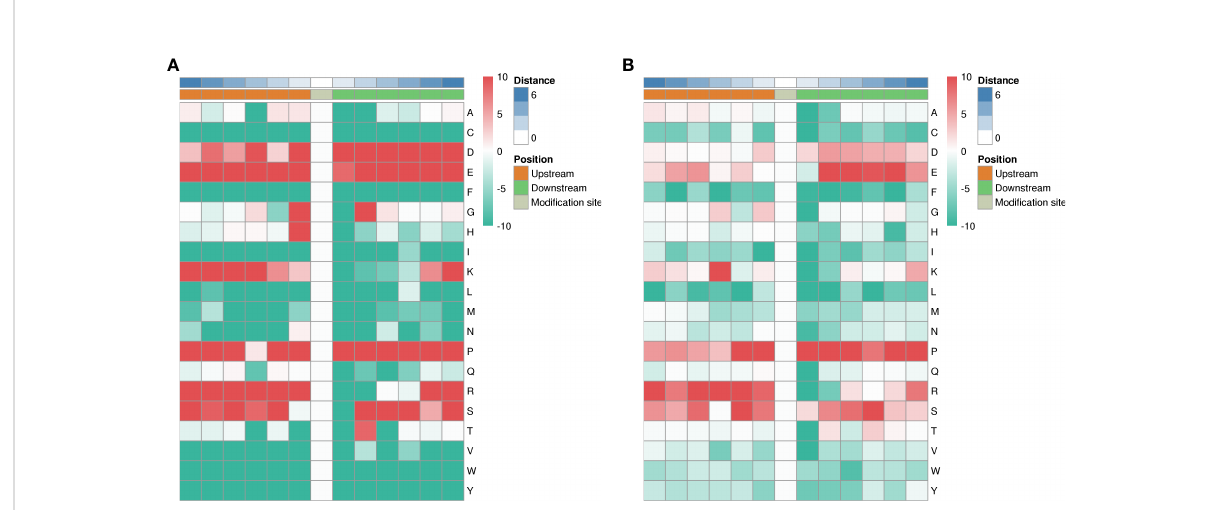
FIGURE 10 Motif analysis of phosphorylation sites. Heat map showing enrichment or depletion of speci fi c amino acids near the serine phosphorylation site. D, E, P, R, and S tend to be near the serine phosphorylation site (A) . P, R, S are largely represented in the proximal region of the threonine phosphorylation site (B)